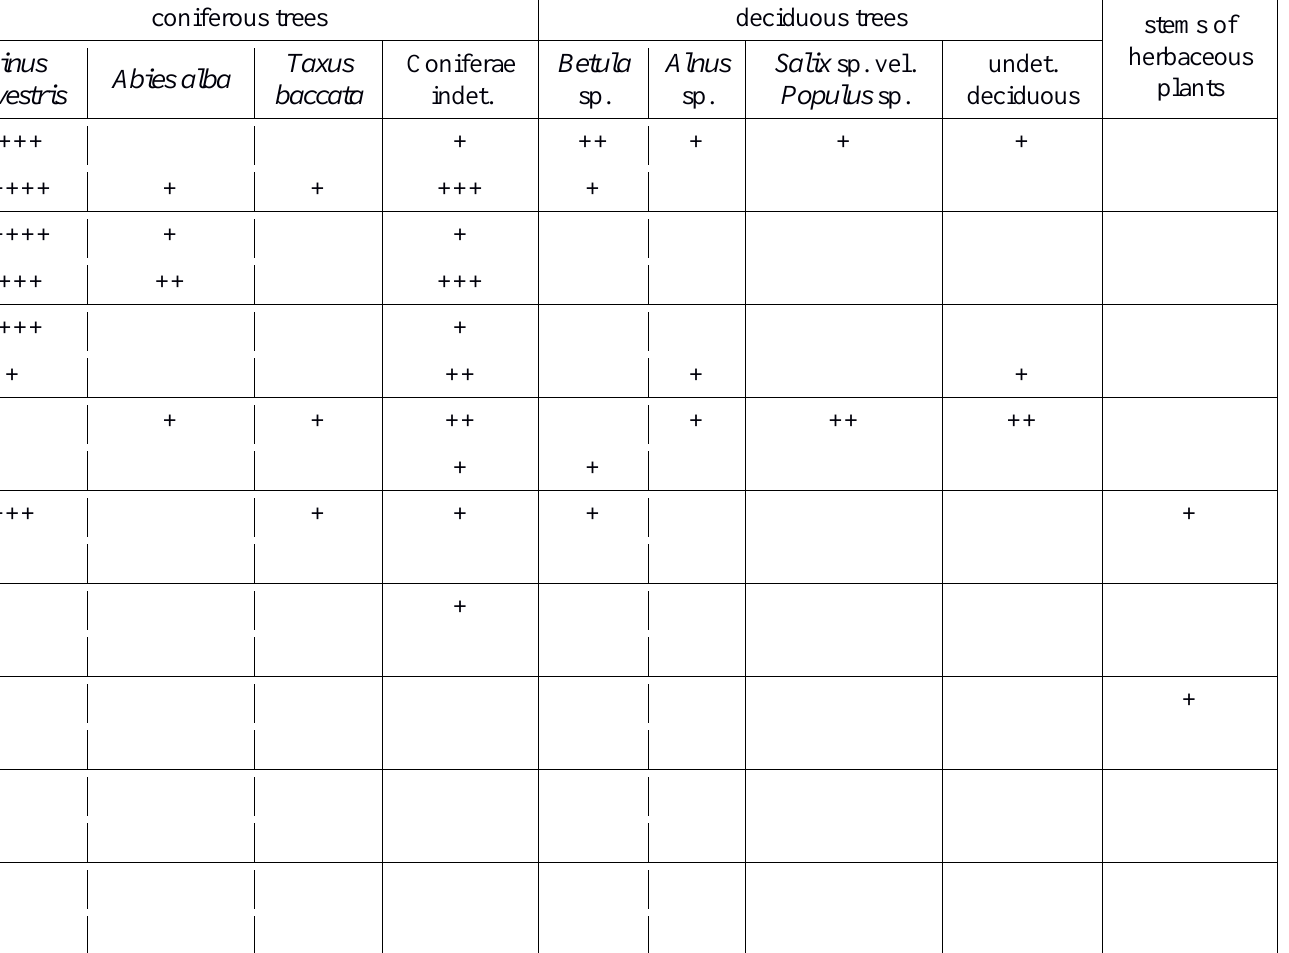
Table 4. Results of the investigation of charcoal from